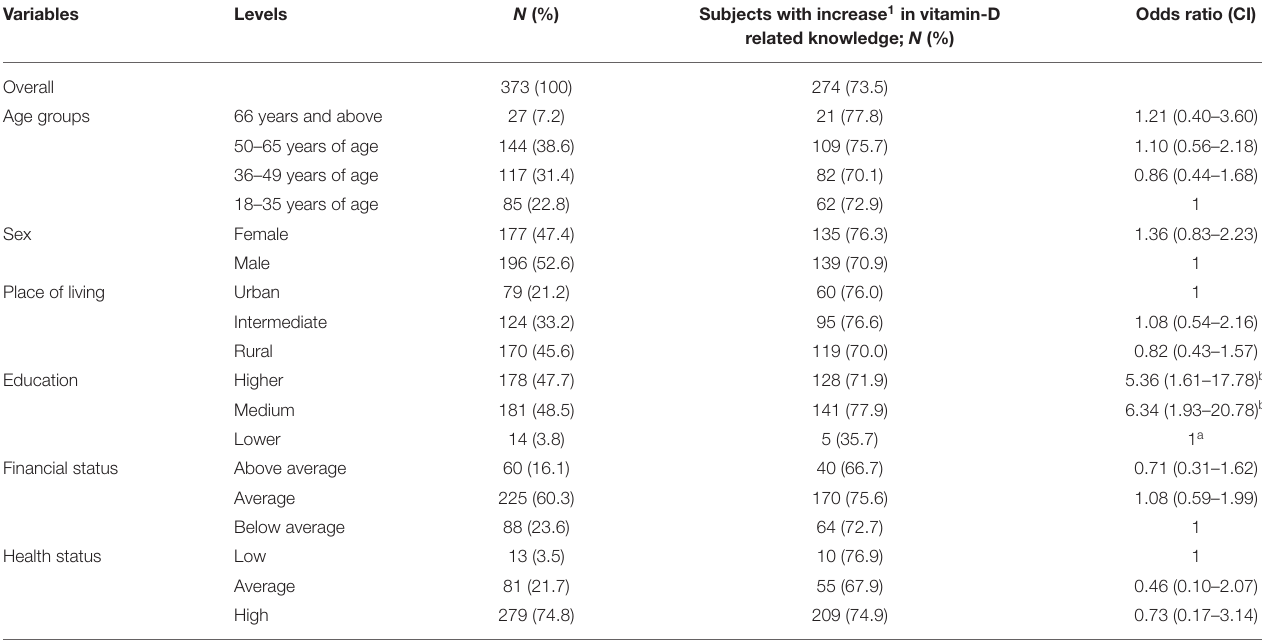
TABLE 4 | Assessment of intervention-related changes in vitamin D-related knowledge by age, sex, place of living, education, financial status, health status, and employment (analyses on N = 373 subjects, included in both April and December 2020 sampling). Variables Levels N (%) Subjects with increase 1 in vitamin-D related knowledge; N